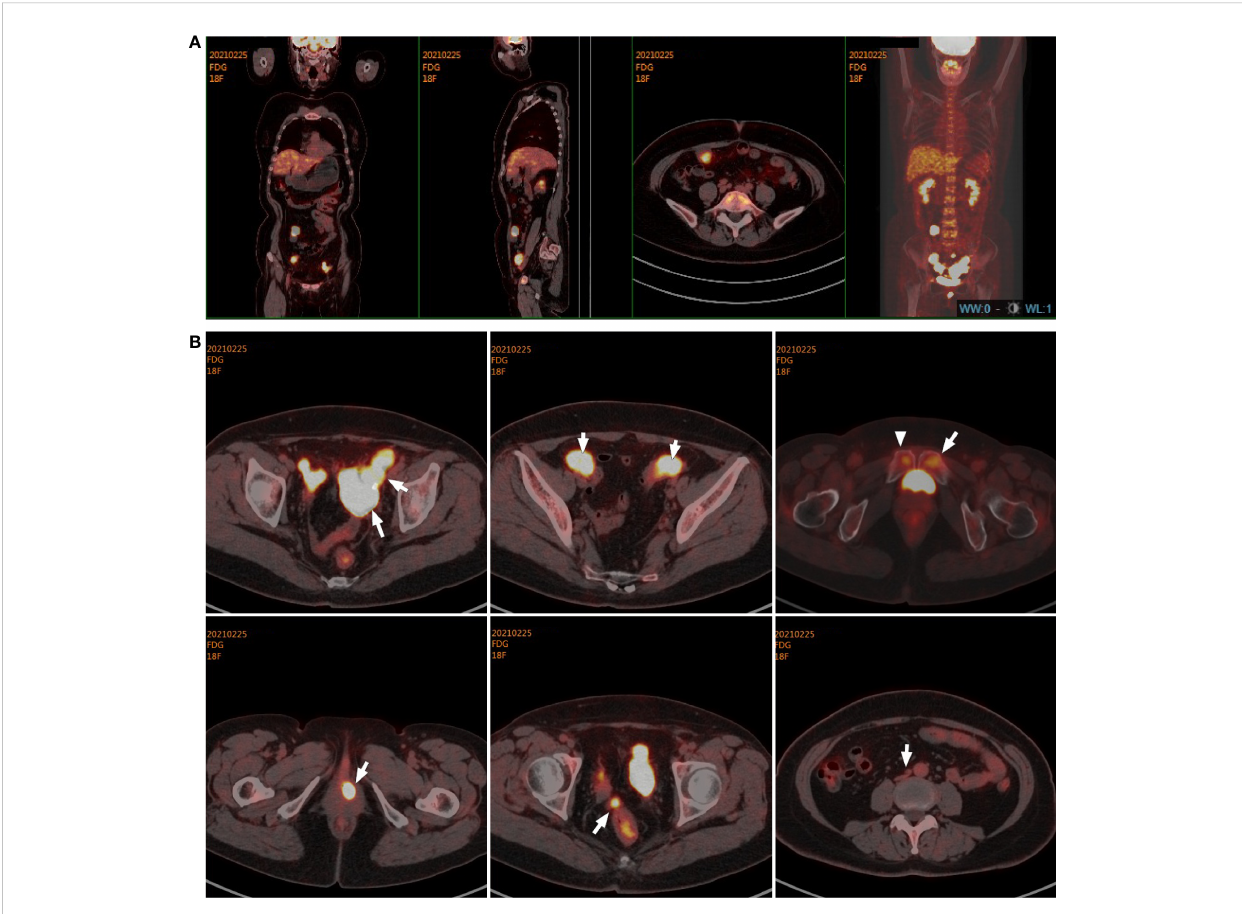
FIGURE 1 Target lesions of the patient with uterine IMT by PET/CT scans. (A, B) PET/CT scans indicated multiple metastases with increased 18 F- fl uoro-2- deoxyglucose ( 18 F-FDG) uptake in the vaginal stump, left-side vulva, abdominal pelvic cavity, mesentery, and iliac paravascular and retroperitoneal lymph nodes in the abdomen and pelvic cavity. IMT, in fl ammatory myo fi broblastic